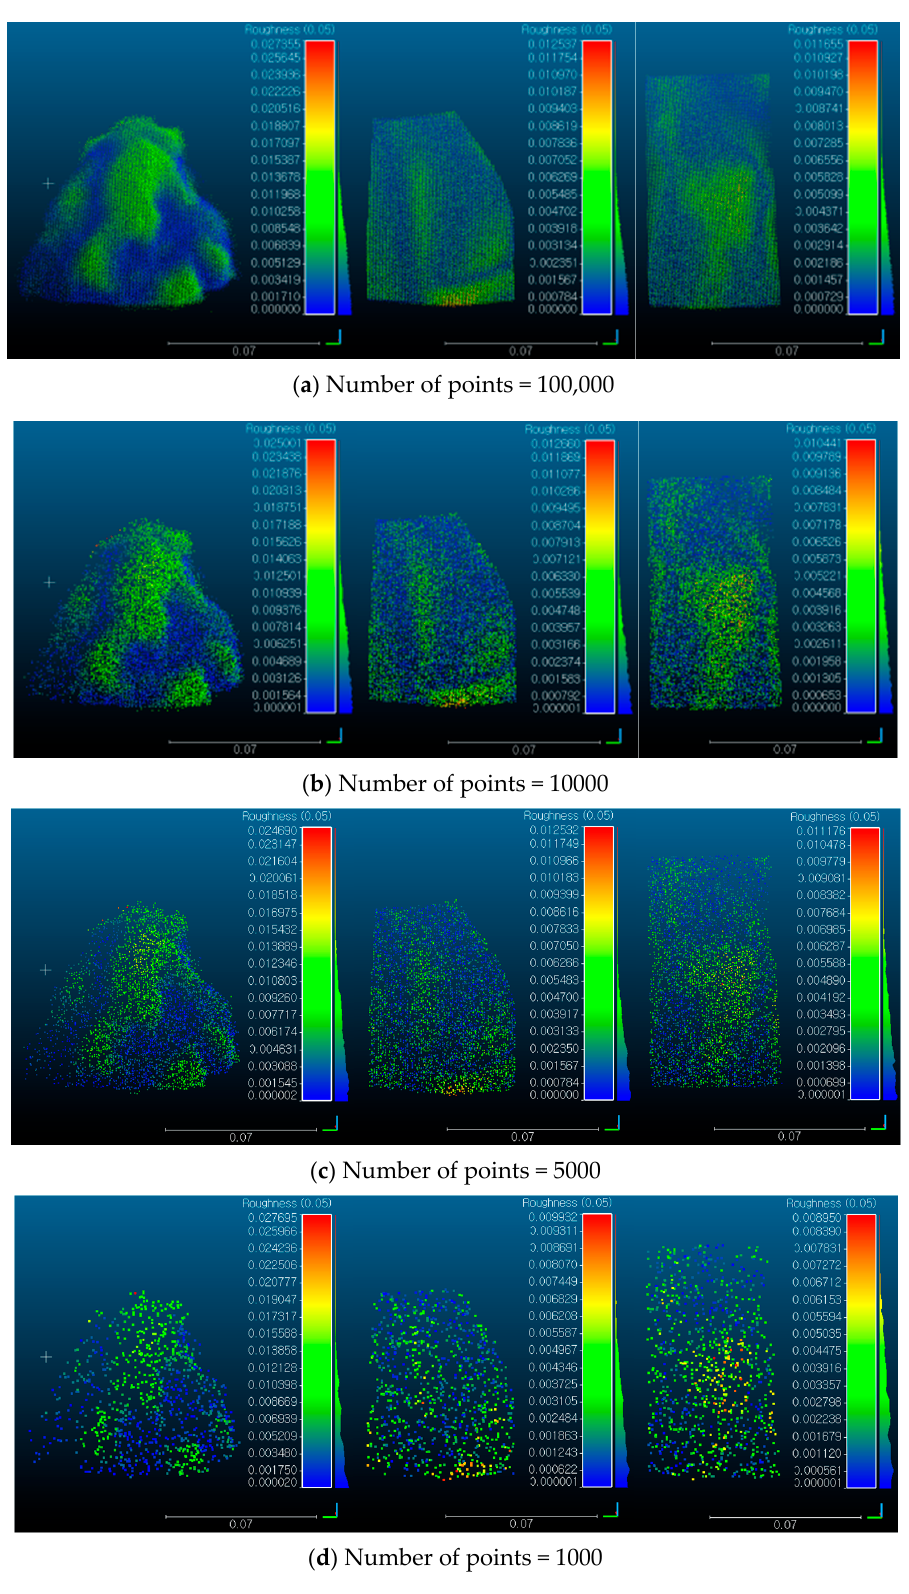
Figure 14. Color scale of roughness with different density of point